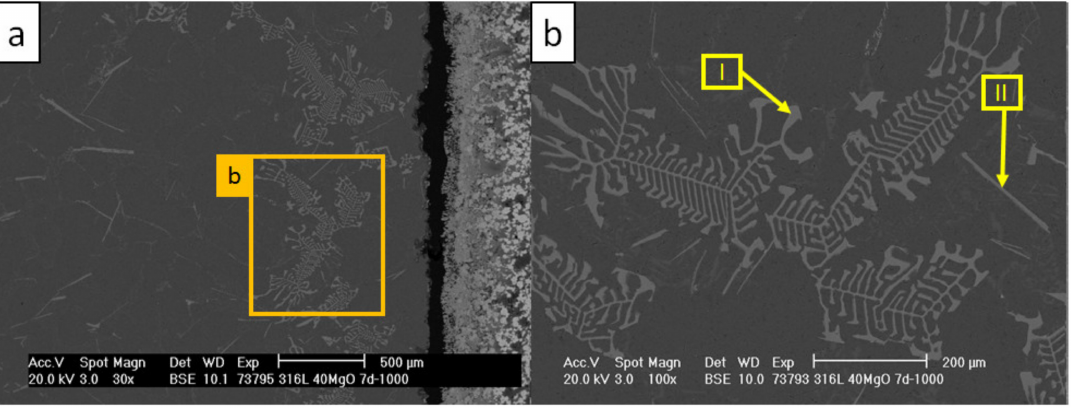
Figure 17. SEM micrographs revealing fishbone-like precipitations in AlSi7Mg0.3 close to the C_1000 interface: ( a ) image magnified to 30 × ; ( b ) image magnified to 100 ×